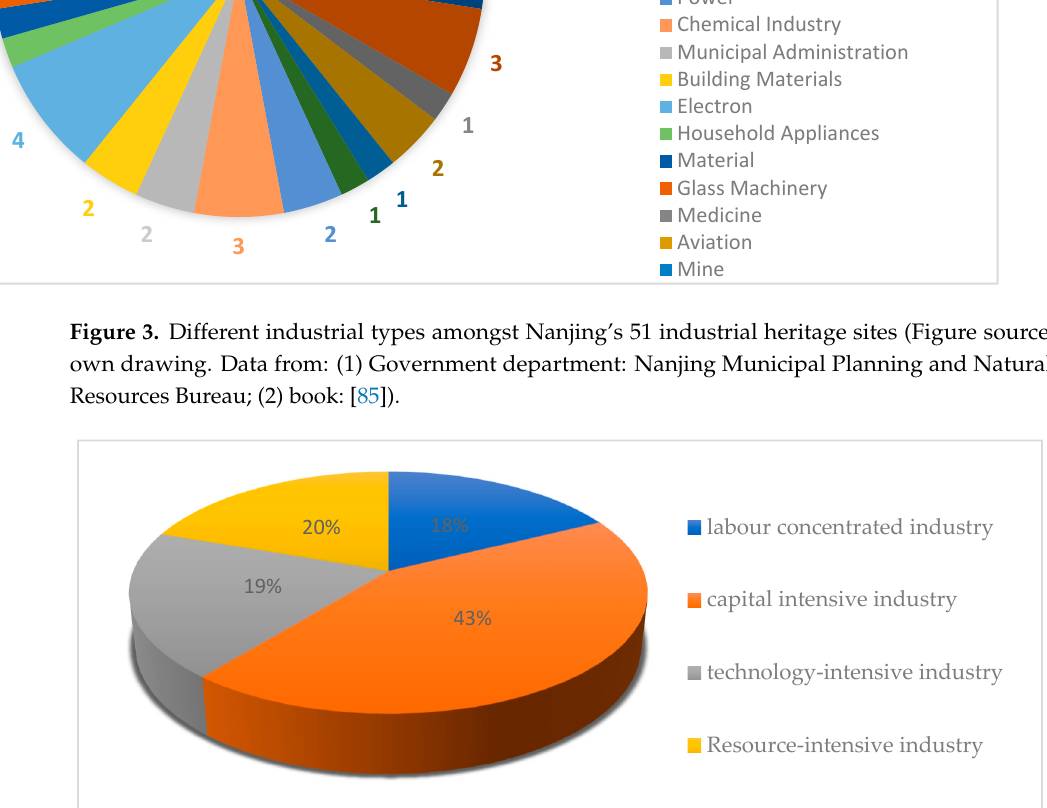
Figure 3. Different industrial types amongst Nanjing’s 51 industrial heritage sites (Figure source: own drawing. Data from: (1) Government department: Nanjing Municipal Planning and Natural Resources Bureau; (2) book: [85]).